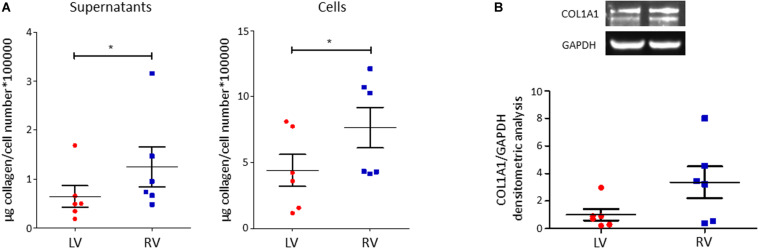
Right ventricle (RV) cardiac mesenchymal stromal cells (C-MSC) produce more collagen than left ventricle (LV) cells. (A) Collagen production quantification with Sircol assay in supernatants (left graph) and cells (right graph) of LV and RV C-MSC cultured for 5 days in the basal medium with 2% serum. As shown in the graphs, RV cells produce more collagen than LV cells. *p < 0.05; n = 6 each (paired t-test). (B) Western blot analysis of COL1A1, the more expressed collagen type, confirmed Sircol result. A trend of higher expression of COL1A1 was evaluated in RV C-MSC. n = 6 each (paired t-test).